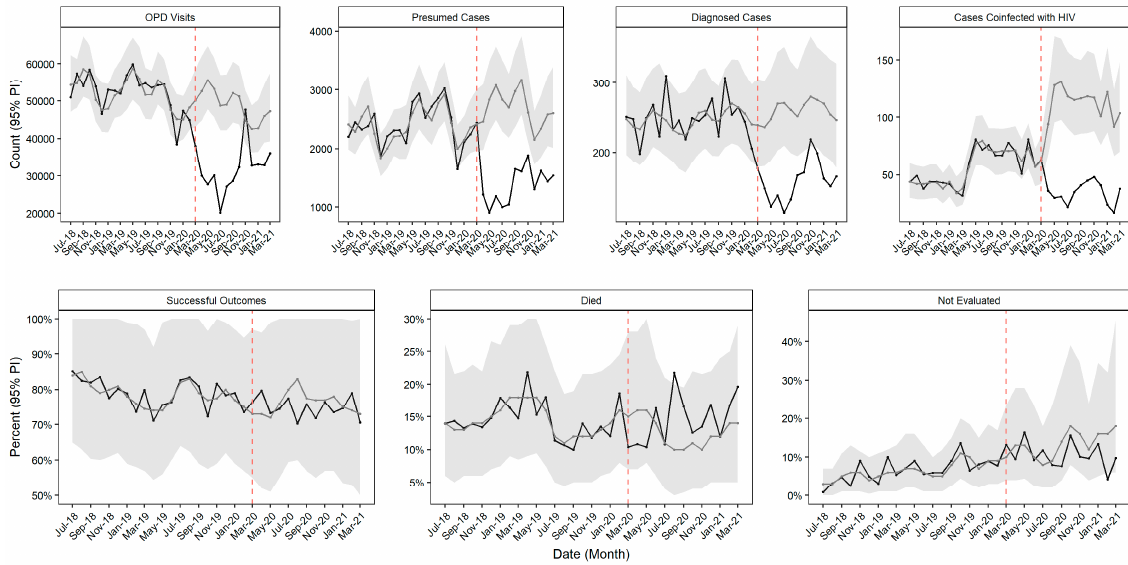
Figure 1. Time series models of seven TB programs, by month and indicator, July 2018 to March 2021. Grey lines show expected values and grey shading indicates 95% prediction intervals; black lines show observed values.